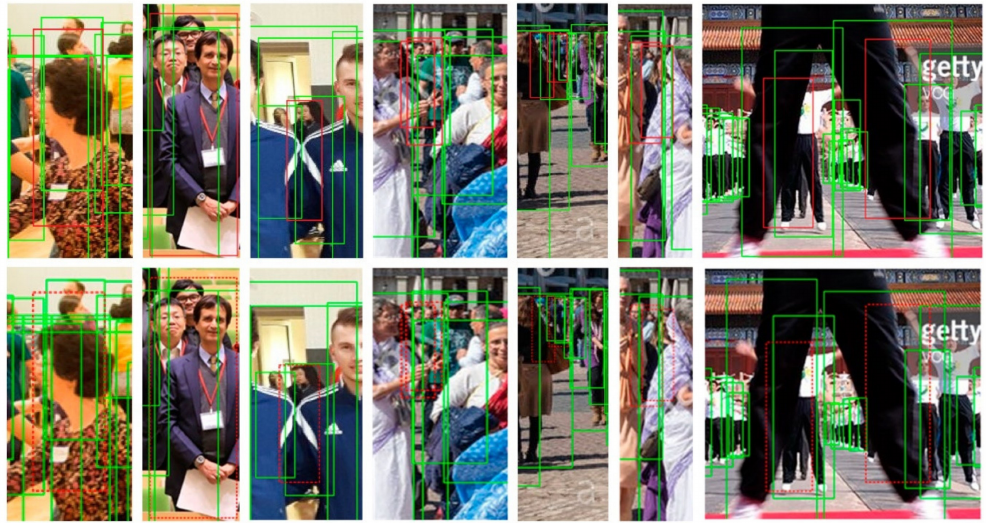
Figure 6. Comparisons of detection results between the ResNet50 and FPN baseline and our method. The images on the first row are the detection results by our method. The last row is the results by the baseline. The solid red boxes are the pedestrians detected by our method but not detected by the baseline method. In contrast, the dashed red boxes are the missed